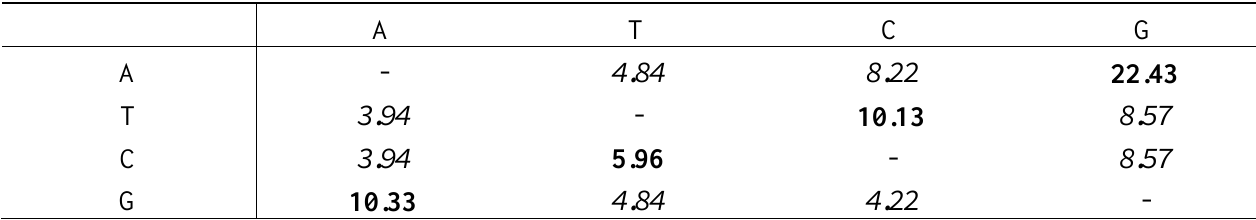
Table 2. Maximum composite likelihood estimate of the pattern of nucleotide